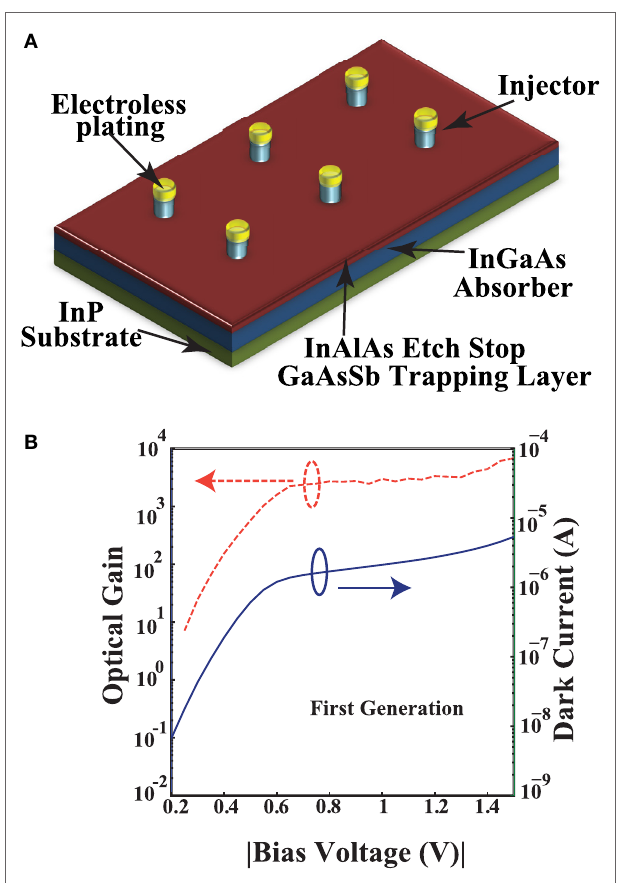
FiGURe 6 | (A) Schematic diagram of first-generation of electron-injection detectors. (B) Plots of electron-injection detector characteristics: dark current and optical gain versus bias voltage characteristic at room temperature. Detectors have 10- μ m injector diameters. Please note that a negative bias is applied to the injector and (B) shows the magnitude of bias